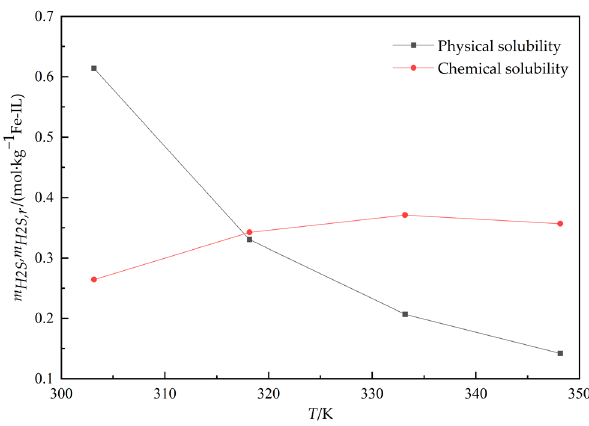
Figure 8. Effects of temperature on physical and chemical solubilities in FeCl 3 /[bmim]Cl at a mole ratio of 0.6 and at 200 kPa.